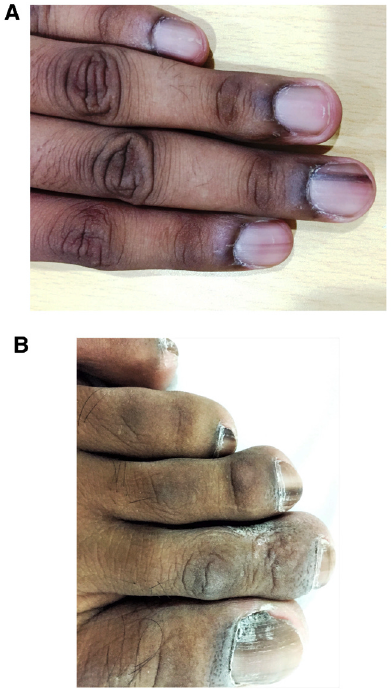
5.Figure 3. Longitudinal melanonychia of multiple (a) fingers of the left hand, and (b) toes of the right foot. Pigmentation of the proximal and lateral nail folds is conspicuous.